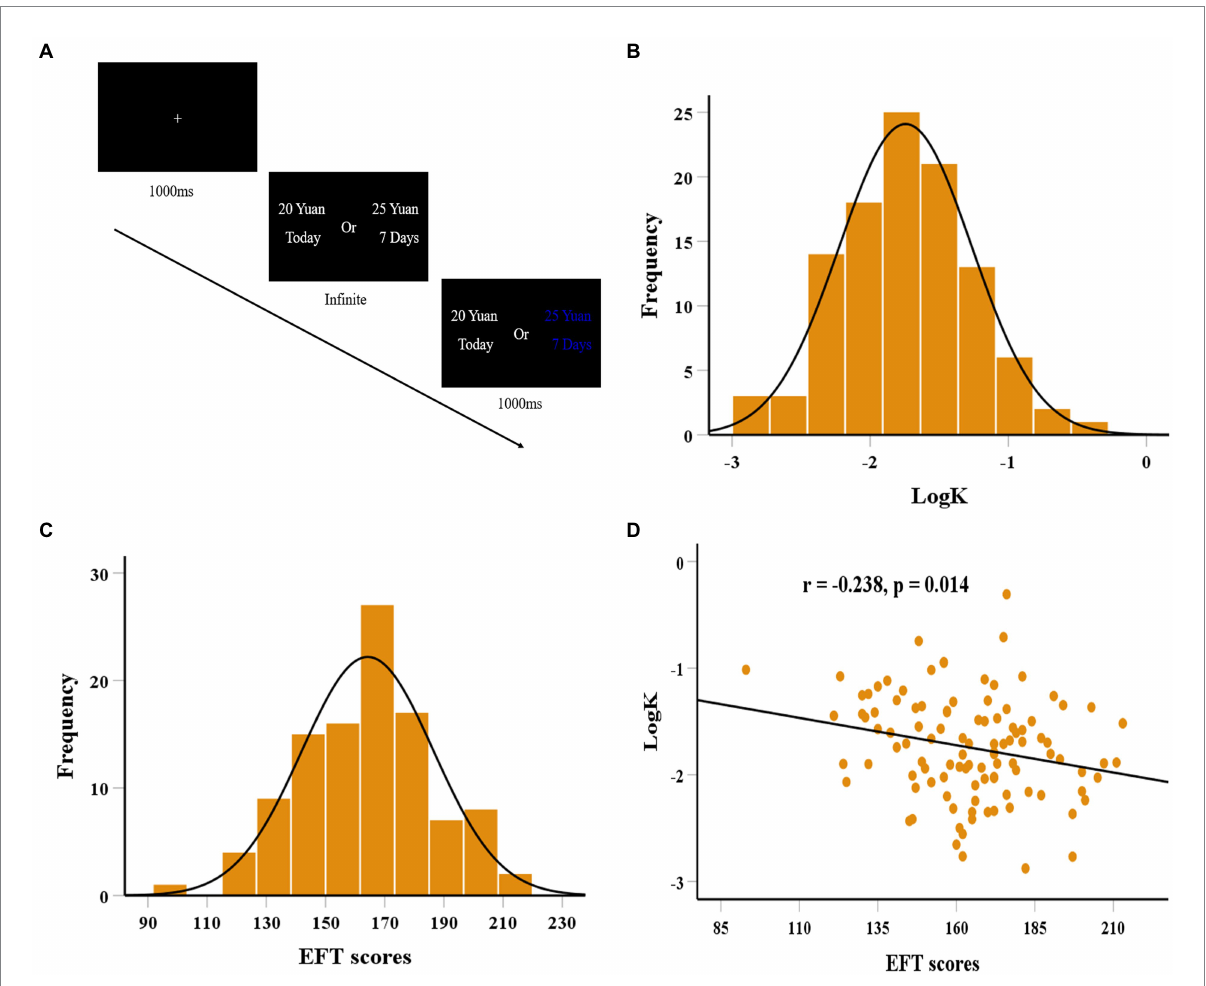
FIGURE 1 The flow chart for the delay discounting task (A) . The distributions of logK (B) and EFT scores (C) . Scatter plot shows the correlation between episodic future thinking (EFT) ability and logK (D)